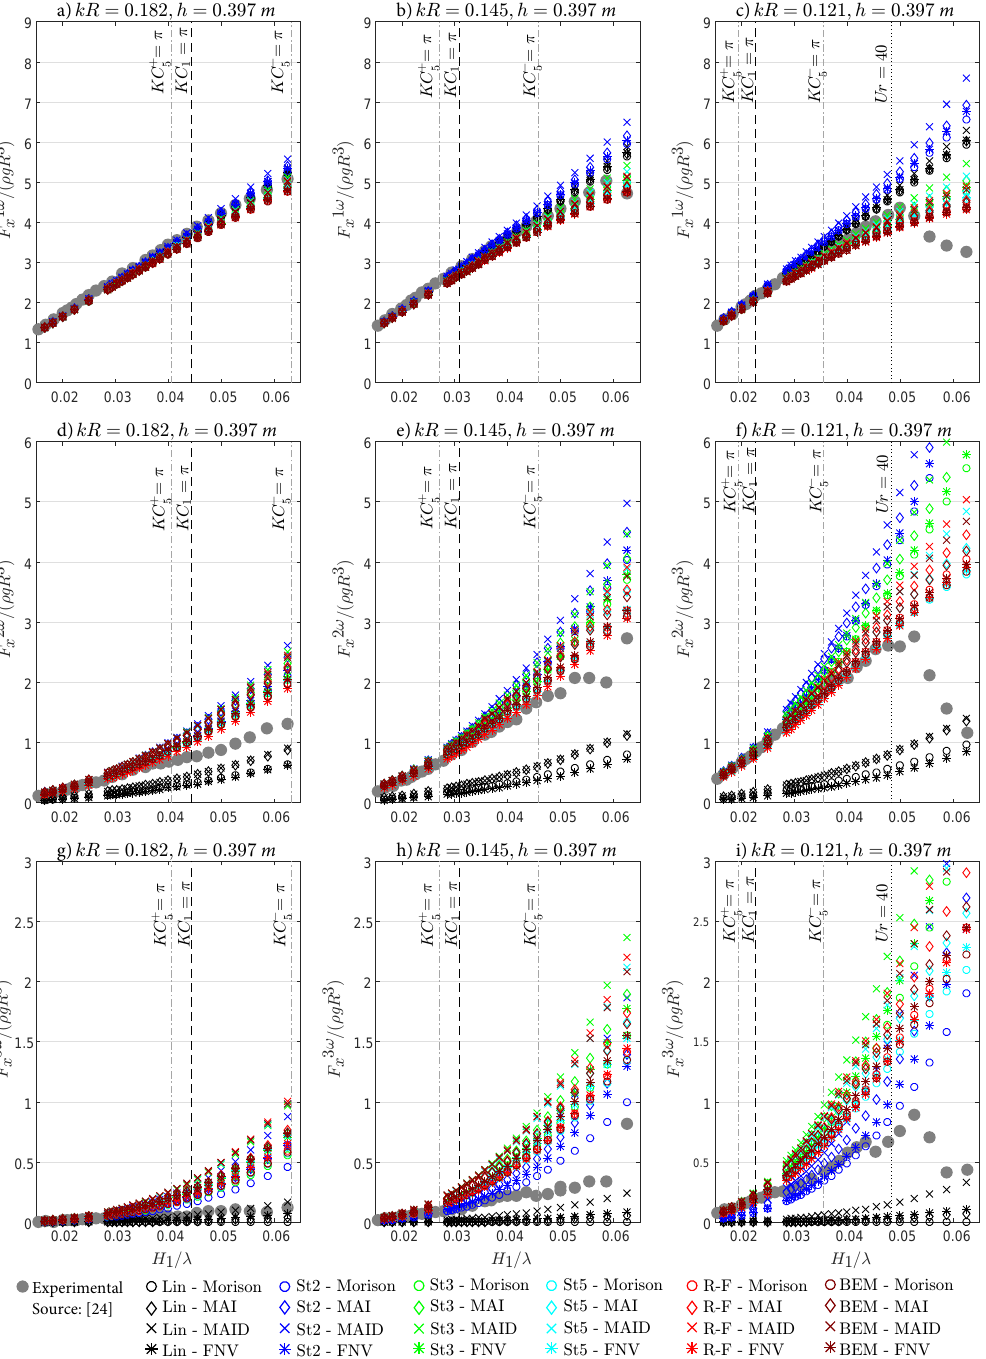
Figure 7. Nondimensionalized horizontal force over the increasing wave steepness H 1 / λ for the depth h = 0.397 m , compared with experiments from [24] (grey dots). First harmonic for wave periods T = 1.443 s ( a ), T = 1.732 s ( b ) and T = 2.021 s ( c ), second harmonic consequently ( d – f ), and third harmonic ( g – i